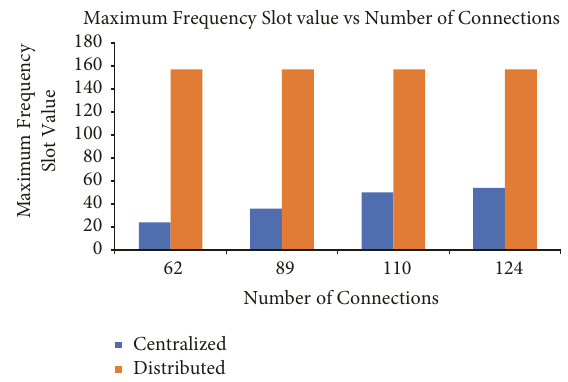
Figure 12: Average connection established time vs number of connections in Germany topology.